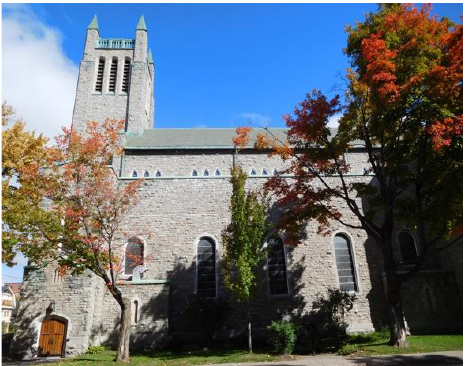
Figure 4. St. Jo seph’s Church, Sandy Hill, Ottawa . Figure 4. St. Joseph’s Church, Sandy Hill,